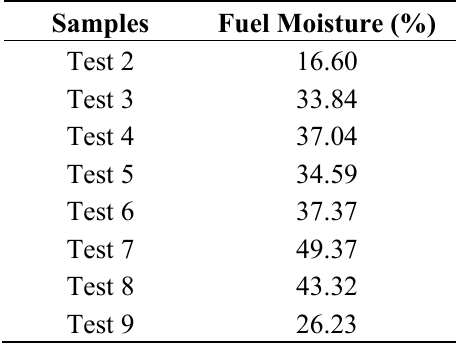
Table 2. Fuel moisture